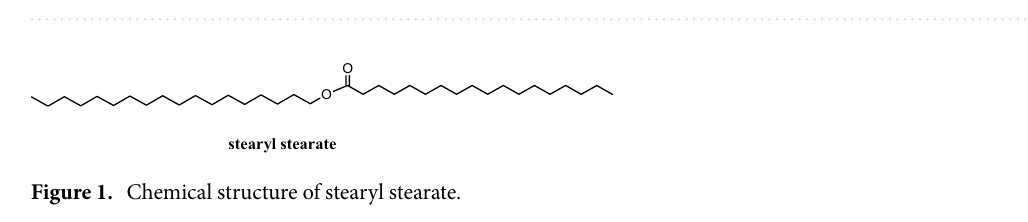
Table 2. Fatty acid composition of buffalo fat. Data are expressed as mean ± SD values given represent means of three determinations.